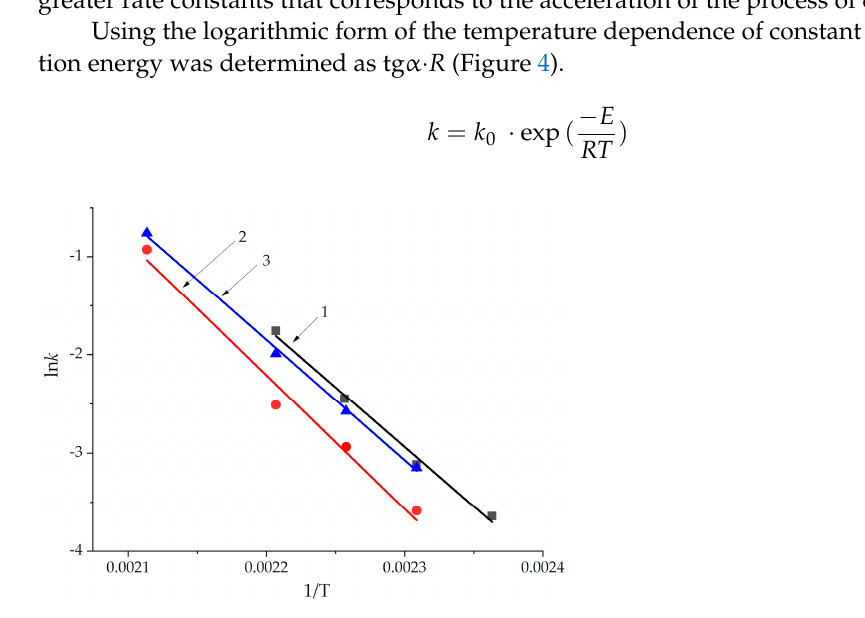
Figure 4. The dependencies of the rate constant logarithm (ln k ) on the reciprocal temperature (1/T) for formulations 1 (black), 2 (red), 3